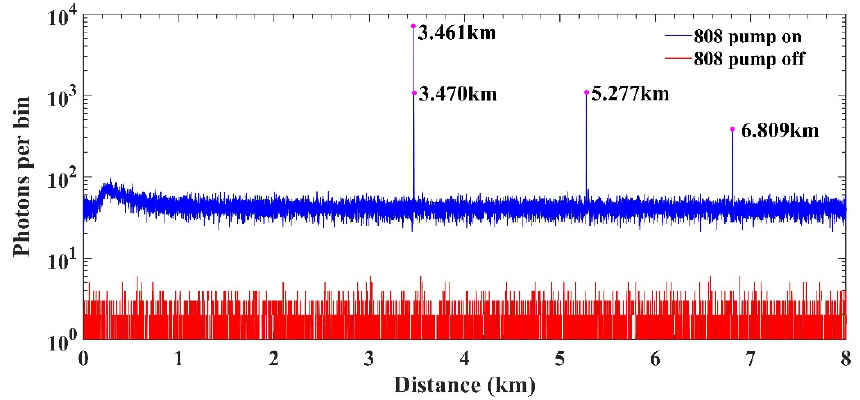
Figure 6. The photon histogram acquired in the hard target ranging test with and without the external pump at 808 nm.